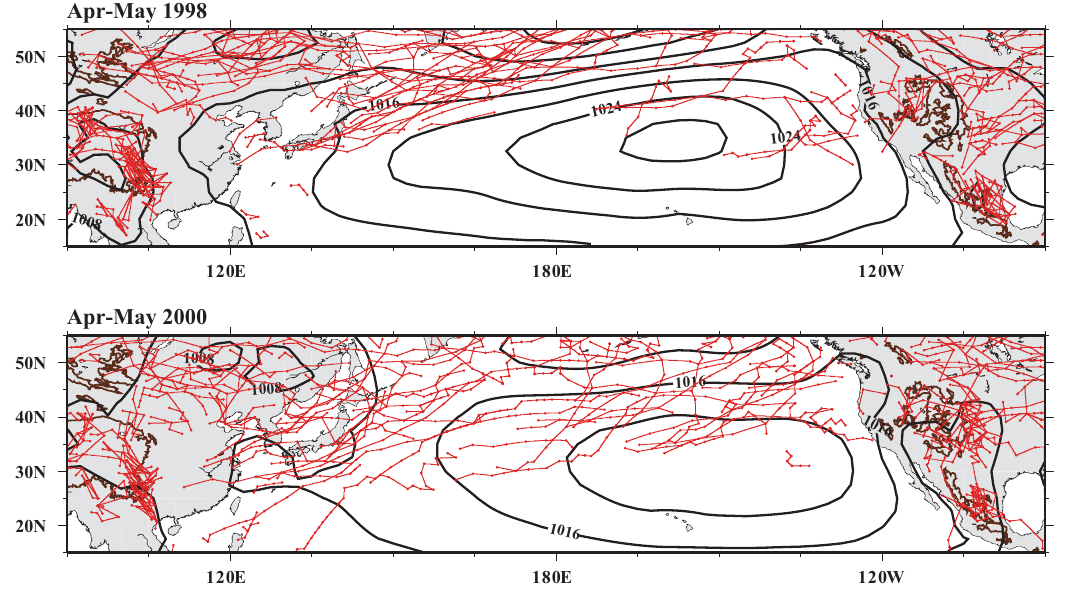
Fig. 11. Spatial distributions of mean sea level pressure overlaid with cyclone tracks during April and May 1998 (top, El Ni˜no) and 2000 (bottom, La Niña). 980